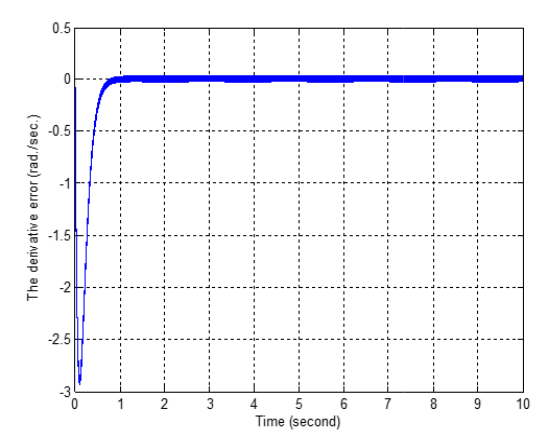
Fig. 18. The derivative error _ ISMC.